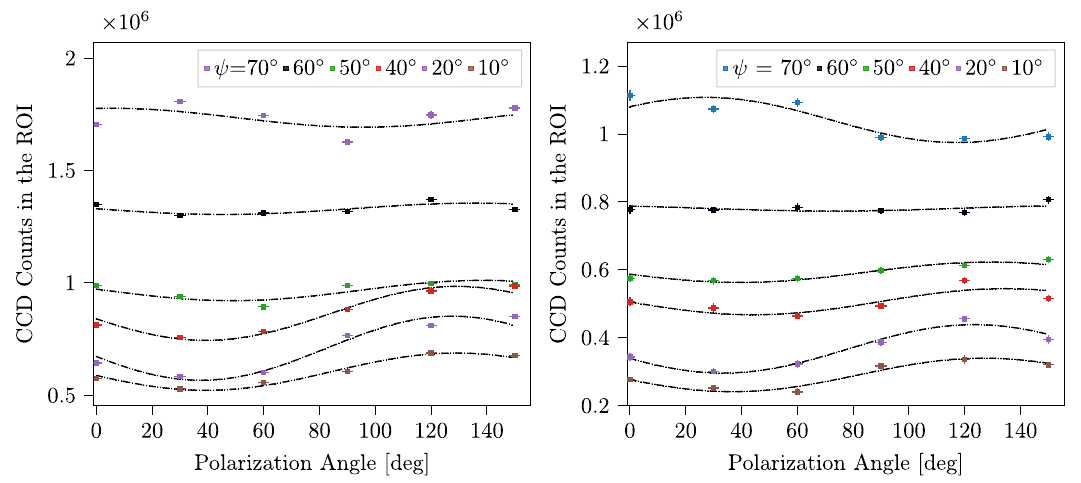
FIG. 13. CCD counts as a function of incidence angle and polarization angle for steel target (left) and glassy carbon target (right).